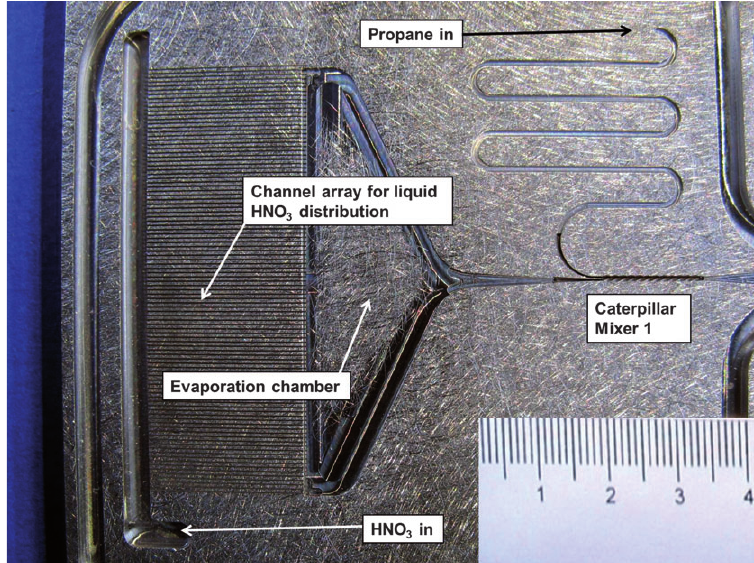
Figure 4 Magnified view of the evaporation and mixing section ( A